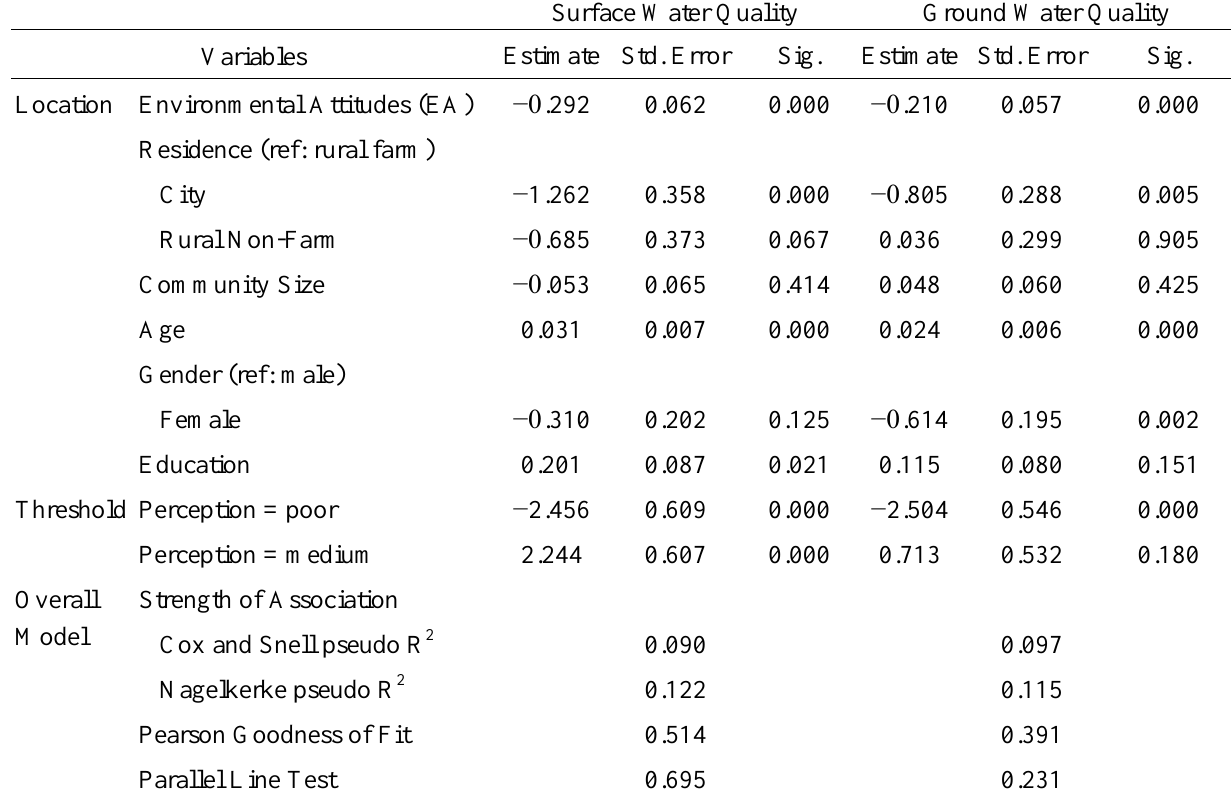
Table 6. Surface and ground water quality perceptions: Ordinal Logistical